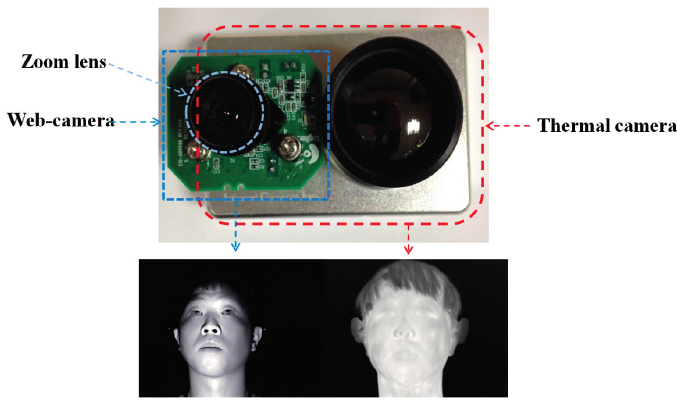
Figure 3. Dual (visible-light and thermal) cameras used in our method and their images.